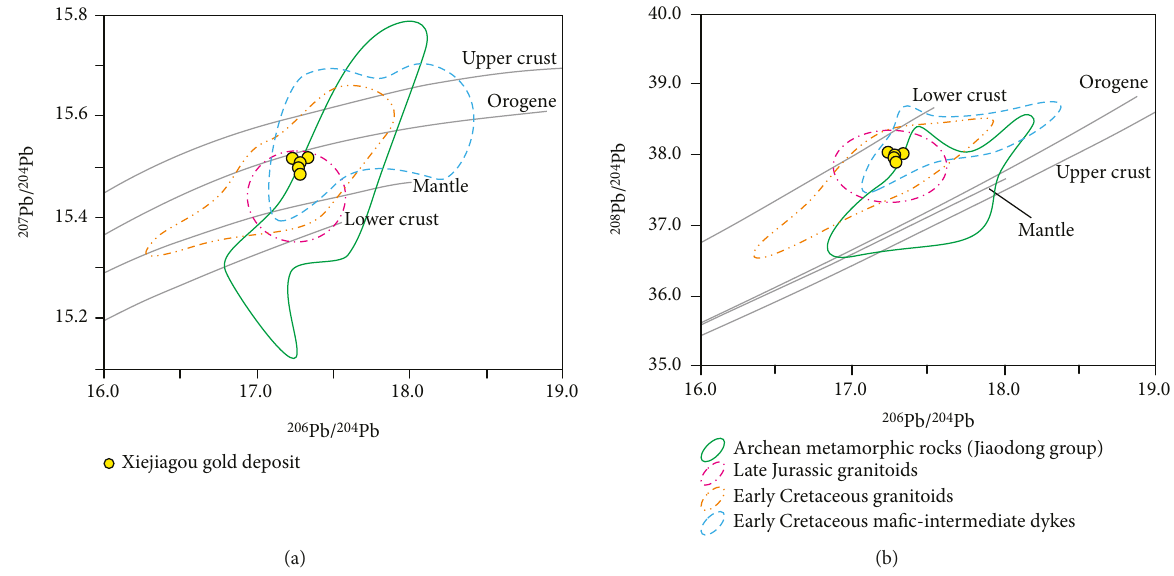
Figure 14: Lead isotopic compositions of sul fi des from the Xiejiagou deposit and related lithologies. The base map from Zartman and Doe [70]. Lead isotopic compositions of di ff erent lithologies at the Jiaodong deposit are quoted from Yang et al. [19] and the references